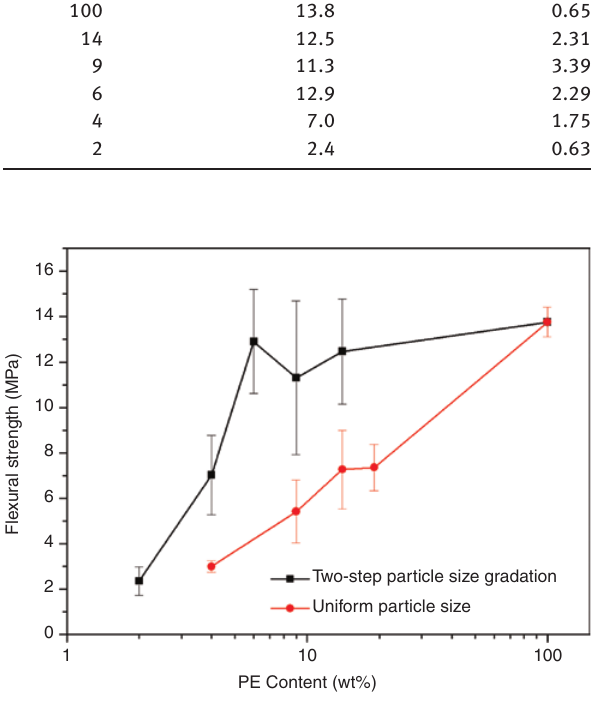
Figure 4 The flexure strength, R , as a function of the PE content, C .